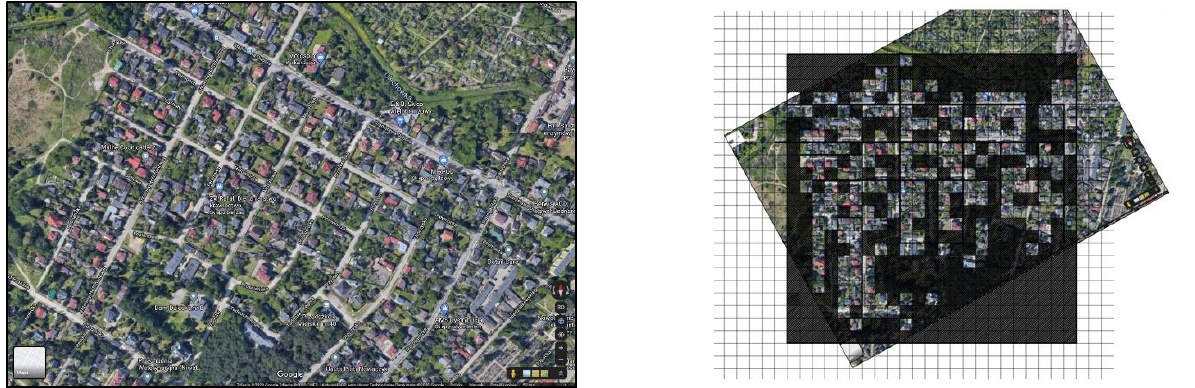
Figure 6. The satellite image of the Smulsko cluster (on left, source: [65]) and its adjustment schema (on right).